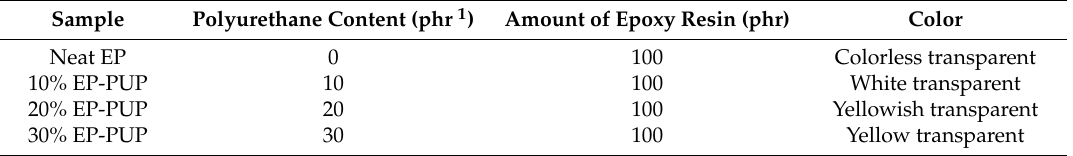
Table 1. Modified epoxy resin formulation. EP: epoxy resin (E-44), EP-PUP: modified epoxy